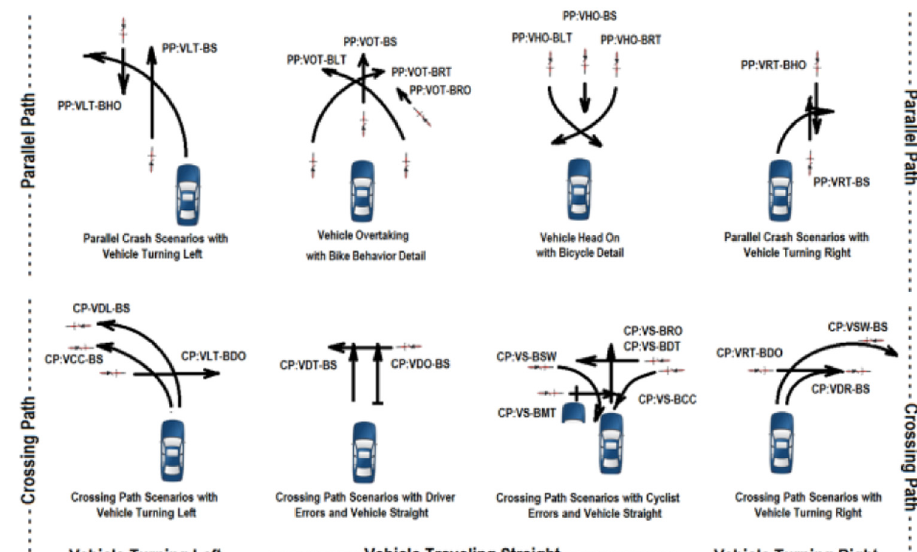
Figure 2 Basic crash